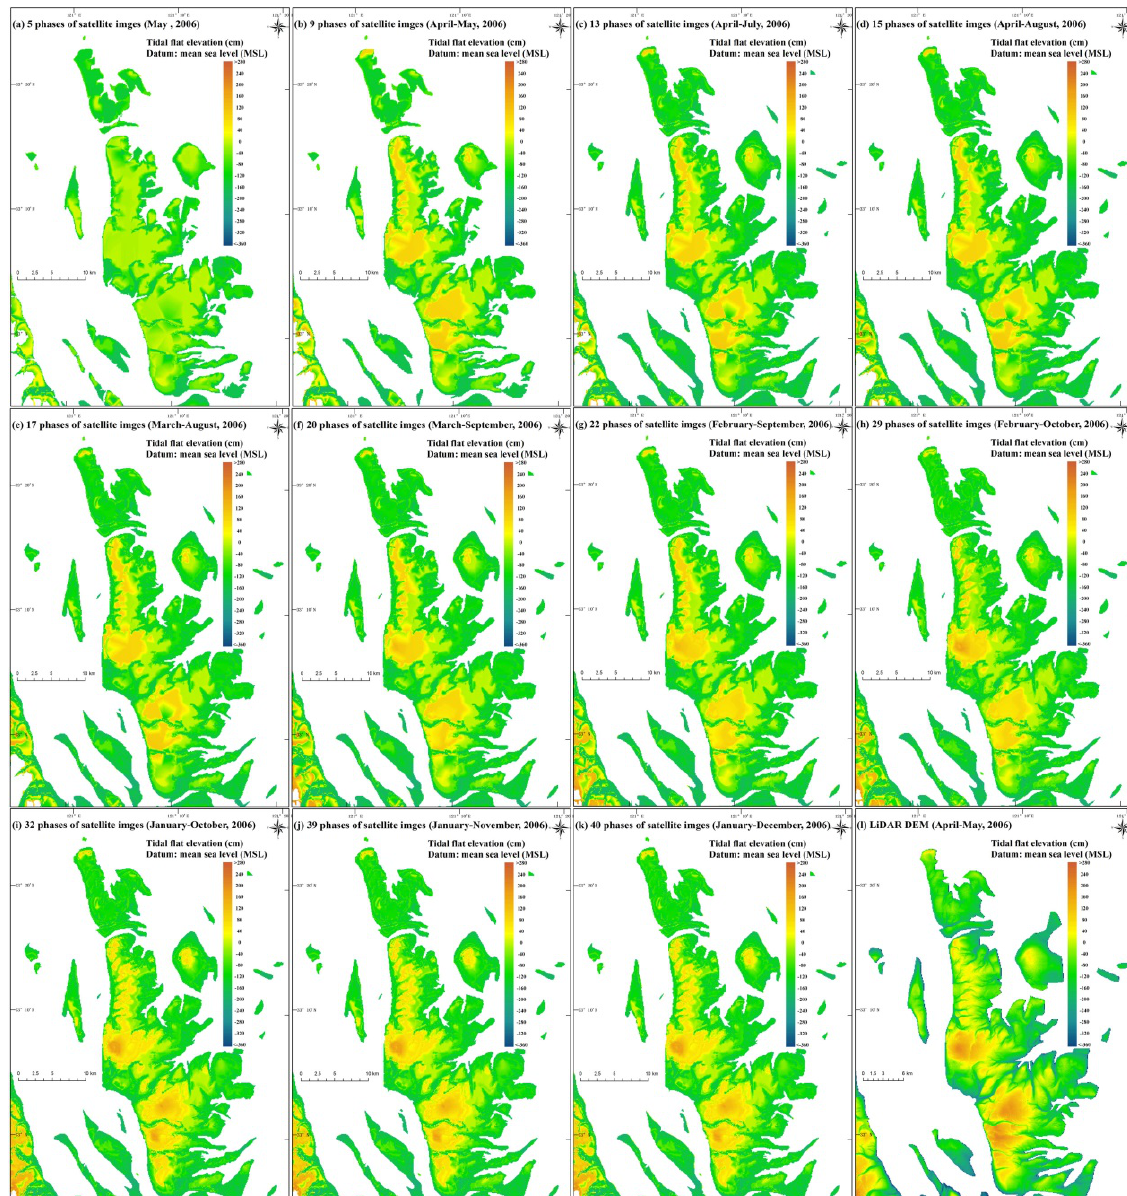
Figure 4. DEMs of the Dongsha Sandbank in 2006 constructed using different numbers of satellite images. ( a ) Five images in May; ( b ) nine images from April to May; ( c ) 13 images from April to July; ( d ) 15 images from April to autumn; ( e ) 17 images from March to autumn; ( f ) 20 images from March to September; ( g ) 22 images from February to September; ( h ) 29 images from February to October; ( i ) 32 images from January to October; ( j ) 39 images from January to November; ( k ) 40 images from January to December; and ( l ) LiDAR DEM measured in April and